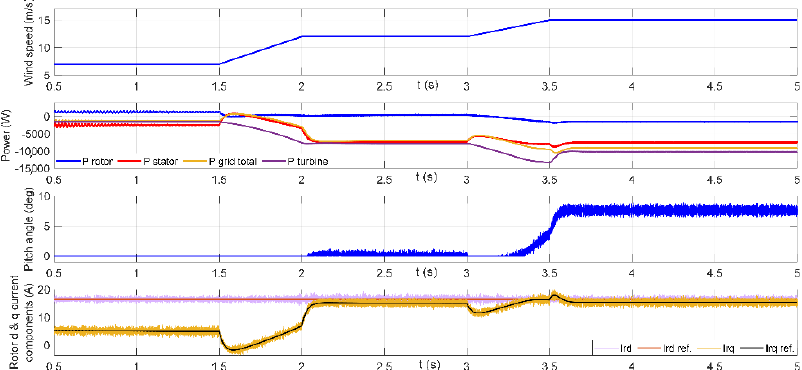
Figure 13. DFIG signals for a wind speed from 7 to 15 m/s. Upper graph, wind speed reference. Second graph, stator, rotor, turbine and total electrical power. Third graph, pitch angle. Fourth graph, references and actual values of rotor current d and q components.